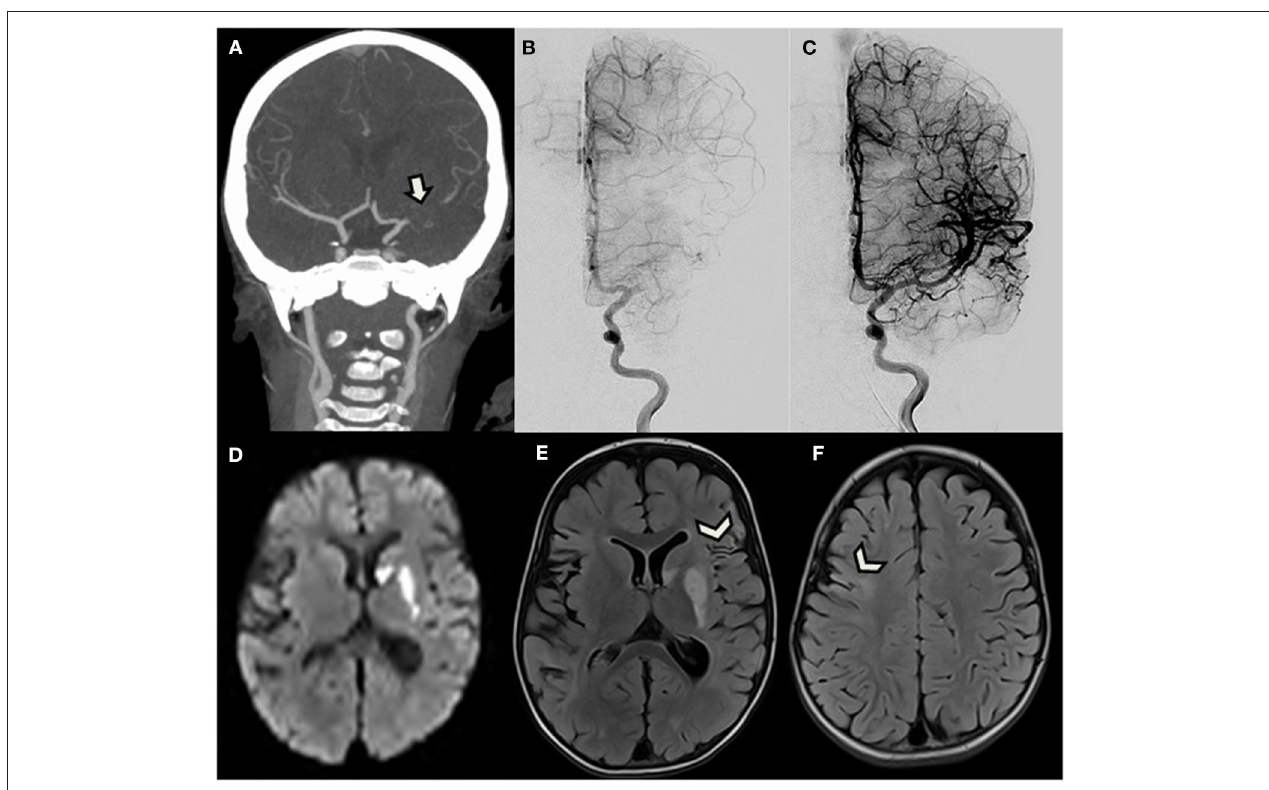
FIGURE 1 | A 2.5-year-old girl with right hemiplegia. (A) Reformatted coronal CT angiogram shows proximal left middle cerebral artery occlusion (arrow) with good collateral flow. (B,C) Antero-posterior view of digital subtracted angiogram initially confirms CTA findings, and then demonstrates complete reopening after successful thrombectomy. (D–F) Brain MRI performed the following day. (D) Axial diffusion-weighted image and (E,F) FLAIR demonstrate acute ischemic stroke only limited to the basal ganglia, corresponding to the same areas with early ischemic signs on initial CT (not shown), without further extension. Images also reveal sequelae of ancient cortical ischemic lesions scattered in both middle cerebral artery territories (arrowheads).